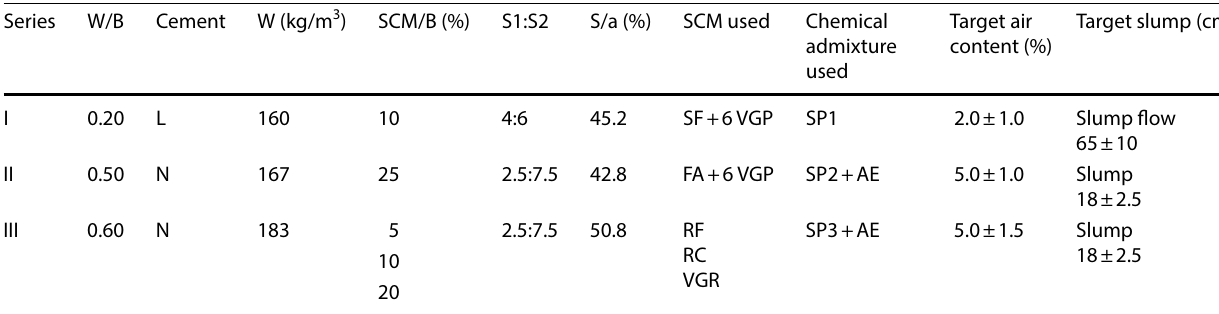
Table 3 Factors and level, mixing proportions